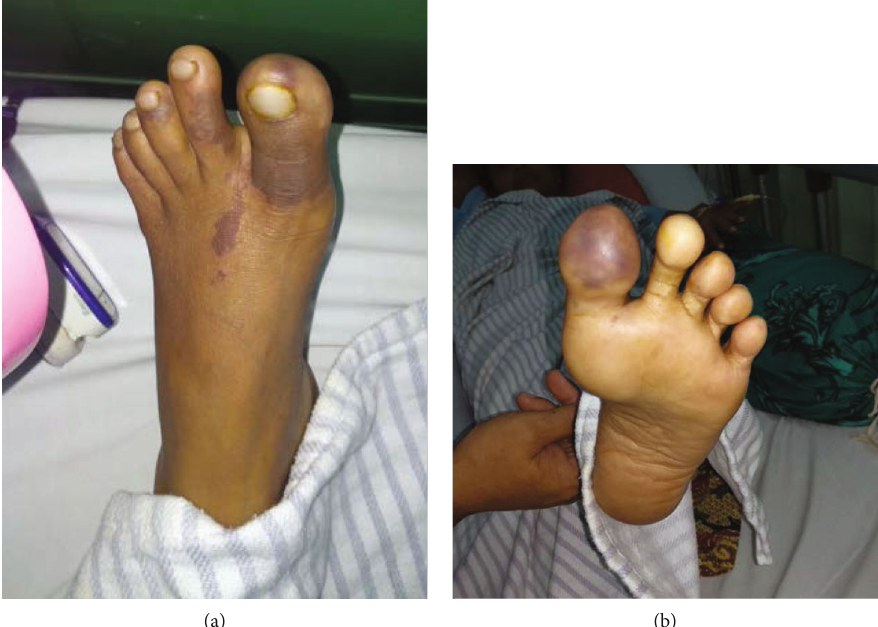
Figure 1: Image of dorsal (a) and ventral (b) views of the left foot in the initial settings with bluish pale area mostly distributed in digits I and